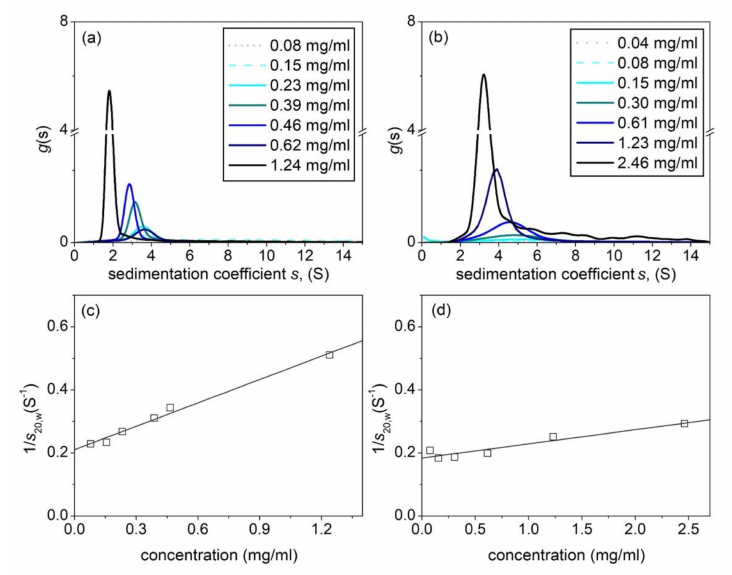
Figure 2. Sedimentation coefficient distributions. ( a ) Hyaluronic acid, HA. ( b ) Tamarind seed polysaccharide, TSP. ( c ) Corresponding concentration extrapolation to zero concentration to eliminate nonideality effects for HA ( d ) Corresponding plot for TSP. Solution pH = 6.8, I = 0.1, temperature = 20.0 ◦ C.